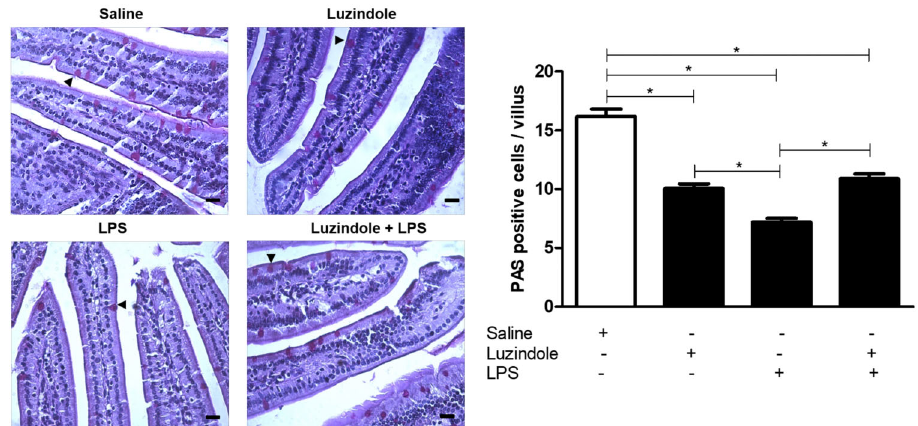
Figure 2. Representative histology of PAS staining in the experimental mouse jejunum after treatment with saline, Luzindole, lipopolysaccharide (LPS), and Luzindole + LPS. Arrowheads indicate goblet cells. Scale bar=20 m m. Graph showing the PAS-positive cells of each group. Data are reported as means ± SE. *P o 0.05 (ANOVA followed by Bonferroni ’ s test).